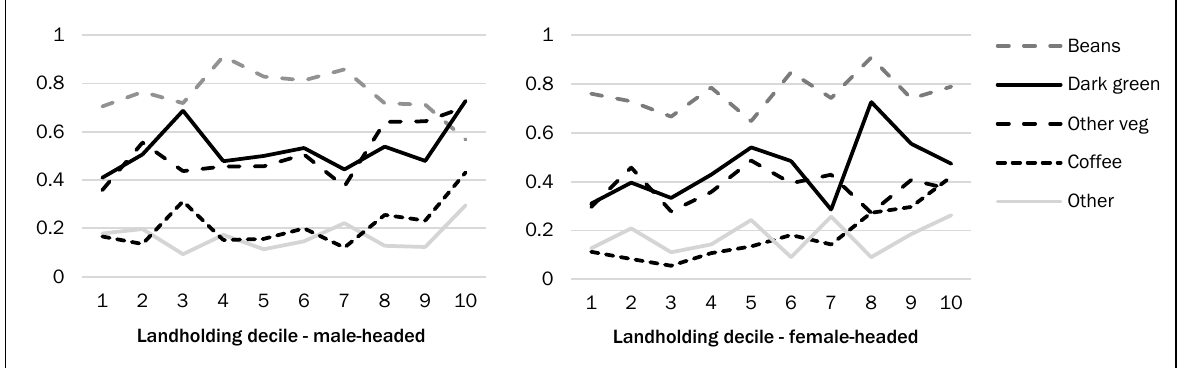
Figure 4. Proportion of Households Growing Income Crop Groups, by Deciles of